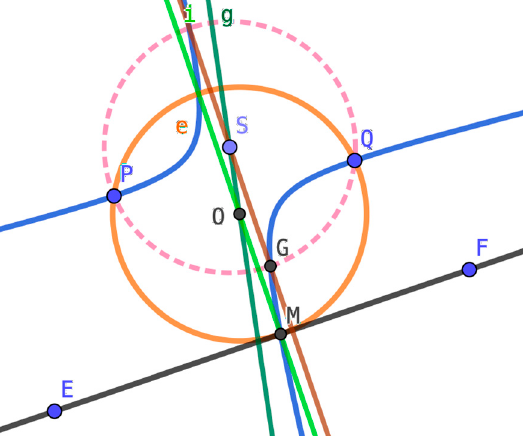
Figure 7. Finding the center of the tangent circle to line EF that passes through points P & Q (https://www.geogebra.org/m/cunnsdav, accessed on 2 January 2021).